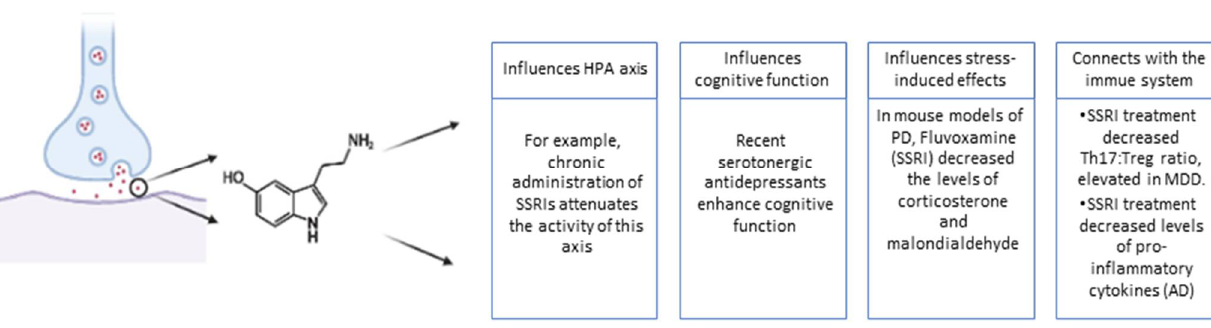
Figure 2. Serotonin, a neurotransmitter with key roles in the process of neuronal transmission, is also an important mediator in the stress and immune responses in several pathologies, such as MDD, AD and PD. In this figure, the chemical structure represents serotonin and the text summarizes some relevant functions of this neurotransmitter in the context of this article. Created with